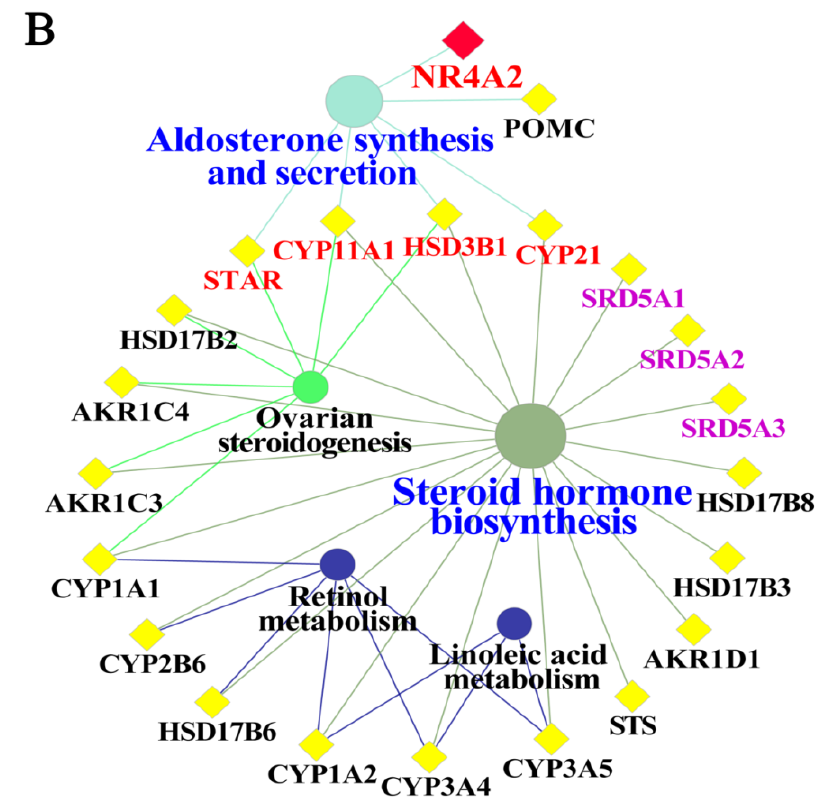
Figure 6. GO and pathway prediction of yak NR1D1 and NR4A2 in reproductive hormone metabolism. A ), Network of GO terms and associated proteins in reproductive hormone metabolism. B ), Network of pathways and associated proteins in reproductive hormone